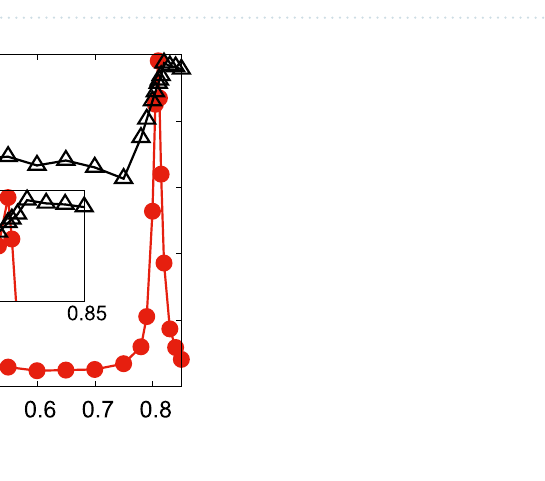
Figure 8. ( a ) Schematic diagrams for the asymmetric 2D double-well potential for transversal resonant tunneling, described in Eq. (6). Here the right well is wider than the left well. Panels ( b ) and ( c ) show the initial density distributions for the ground and longitudinally-excited states, respectively.